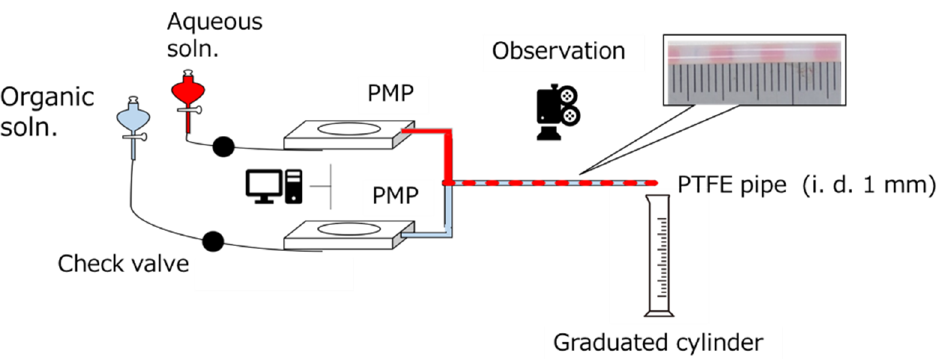
Figure 2. Experimental setup. Solutions listed in Table 1 were stored in a dispensing funnel and connected to a PMP using tubing with a check valve. A controller was used to control the diaphragm of the PMP. Aqueous and oil solutions were combined in a polypropylene T-type connector with an inner diameter of 1 mm. After merging, the liquid formed a slug flow and flowed through the transparent PTFE tube. We measured the slug length by first video recording the slug flow and then converting it into a still image.